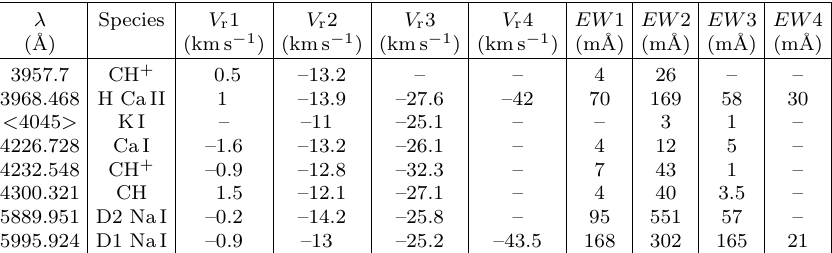
Table 3. Interstellar line